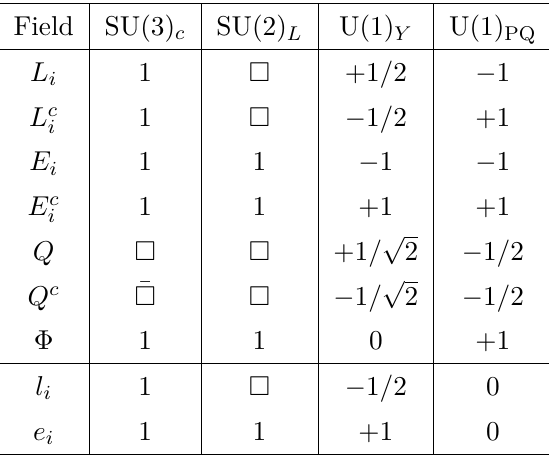
Table 2 . Charge assignment for the UV